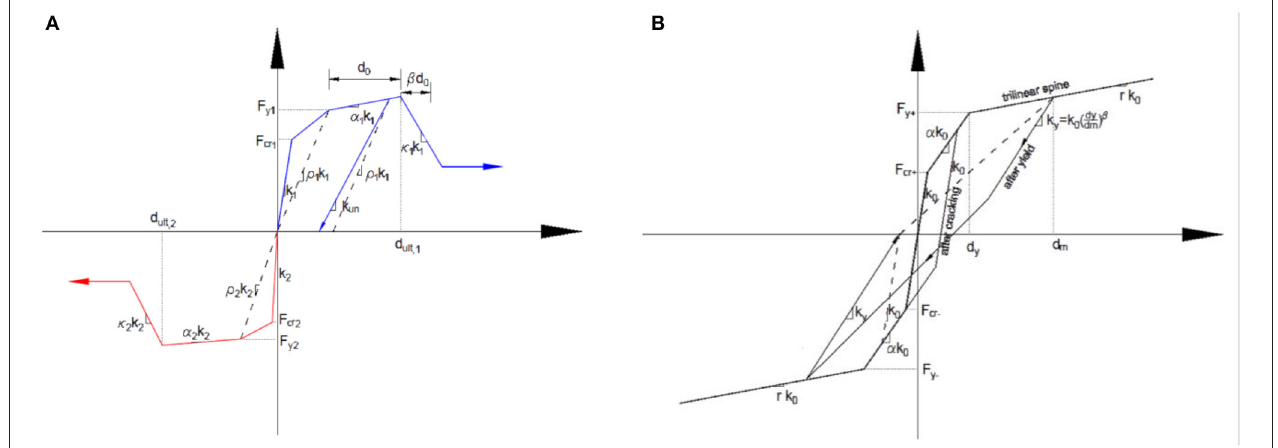
FIGURE 2 | (A) Backbone curve of Schoettler–Restrepo rule (Carr, 2007); (B) Fukada degrading tri-linear hysteresis rule (Fukada,